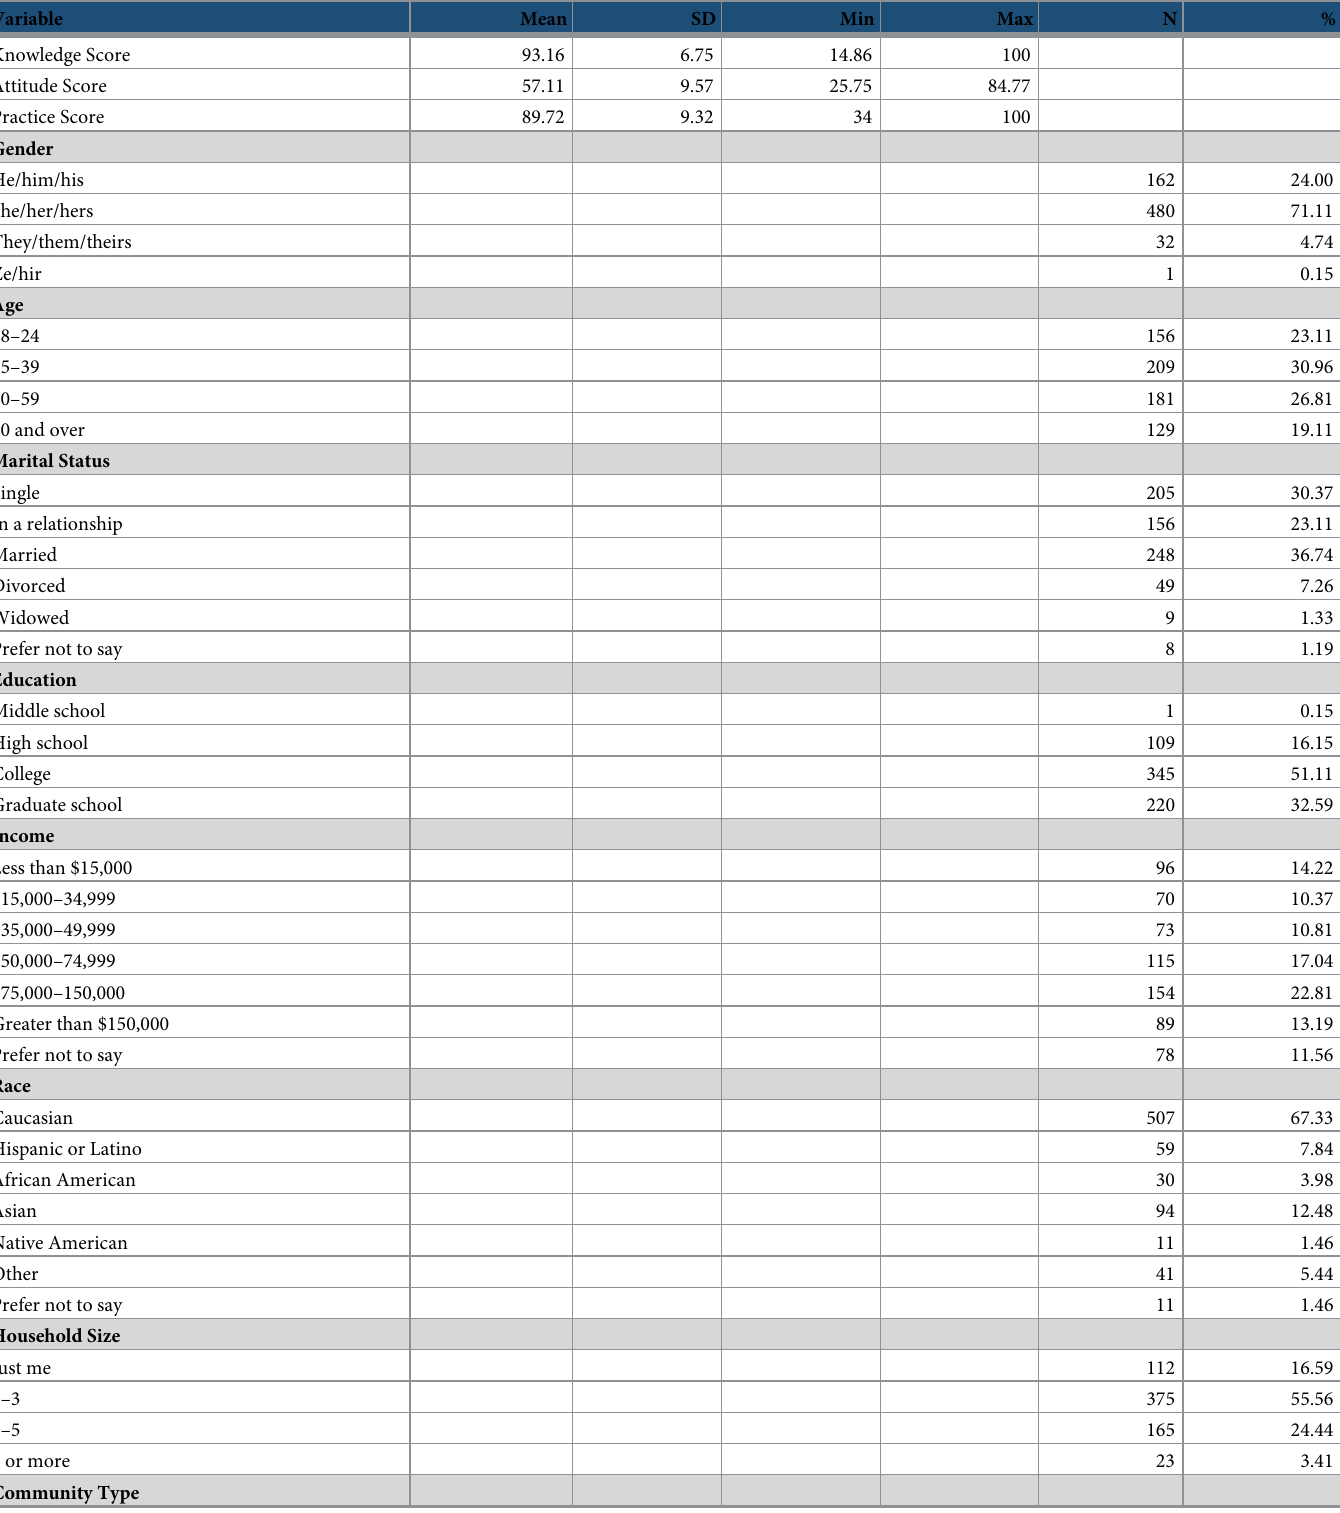
Table 1. Demographic statistics of participants and KAP